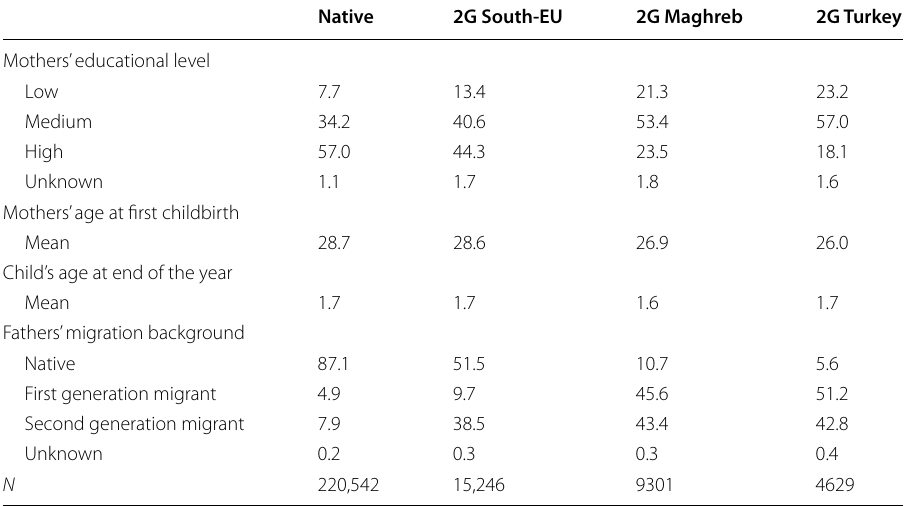
Households with one mother whose child is aged 9 months–2.5 years Excluding households with more than 1 child Additionally excluding households in which mothers do not co-habit with the father (i.e., final selection) Source: Belgian Census 2011 linked to longitudinal register data, longitudinal tax return data on childcare expenses and municipality-level data on childcare coverage from K&G and ONE. Calculations by authors Table 2 Distribution of the covariates and sample sizes by mothers’ origin group among two-parent households with one child (in